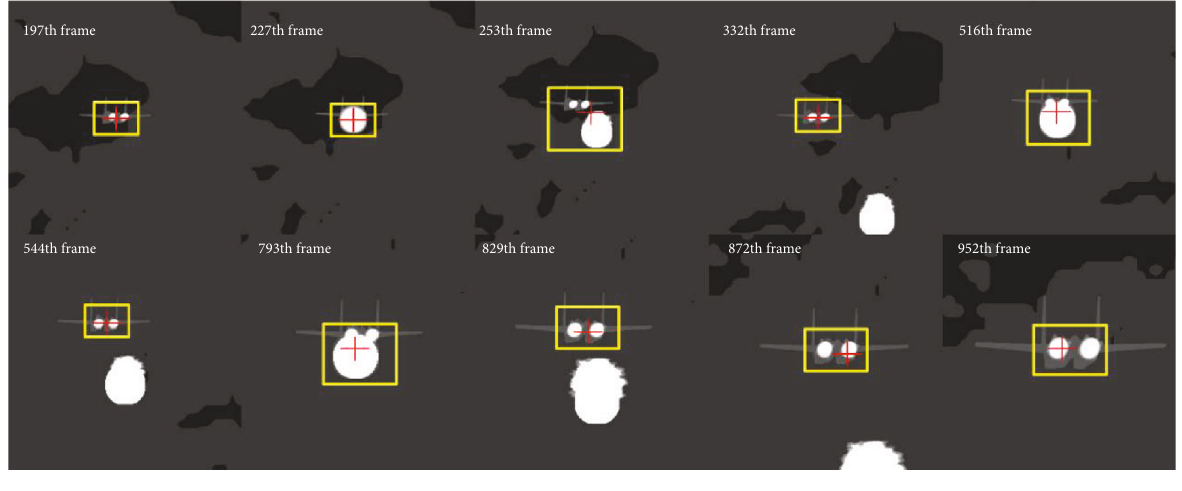
Figure 2: Simulated IR image sequences in the fi eld of view.